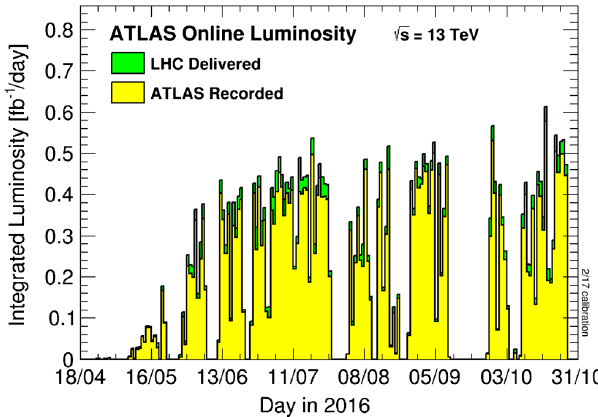
FIG. 7. Integrated luminosity per day delivered to (green) and recorded by (yellow) ATLAS during stable beams for p þ p collisions at 13 TeV center-of-mass energy in 2016. All the details about the time profile of luminosity delivered to ATLAS in 2016, 2017, and 2018 runs can be found in